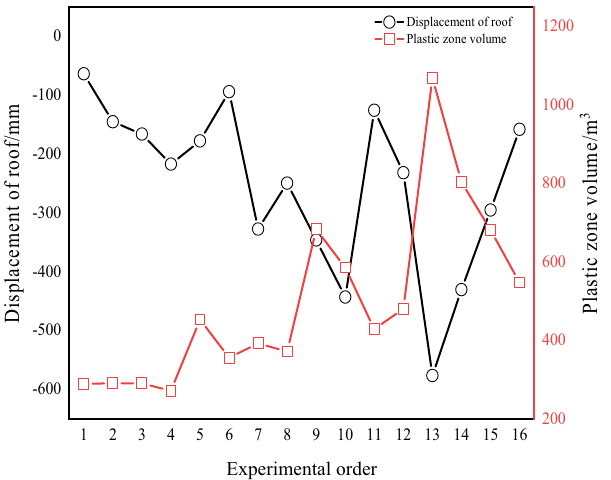
Figure 17. The maximum displacement of the roof and the volume of the plastic zone.